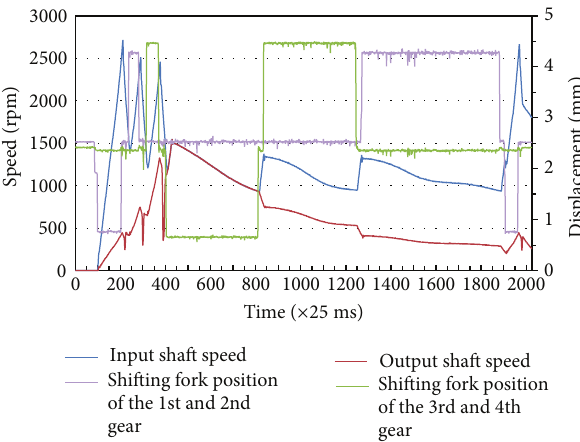
Figure 12: Test results of shifting process.